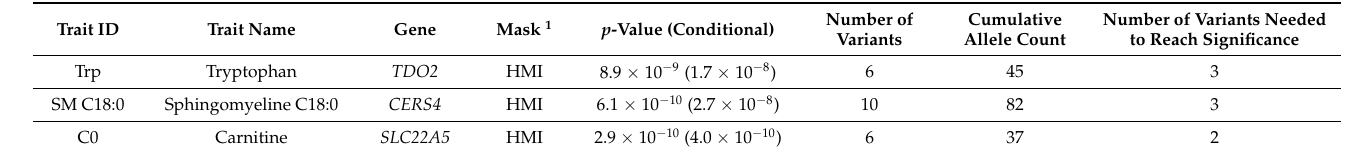
Table 3. Gene-trait associations significant (unconditioned) at a 3.55 × 10 − 8 threshold in the WES combined dataset, with at least two variants needed to reach